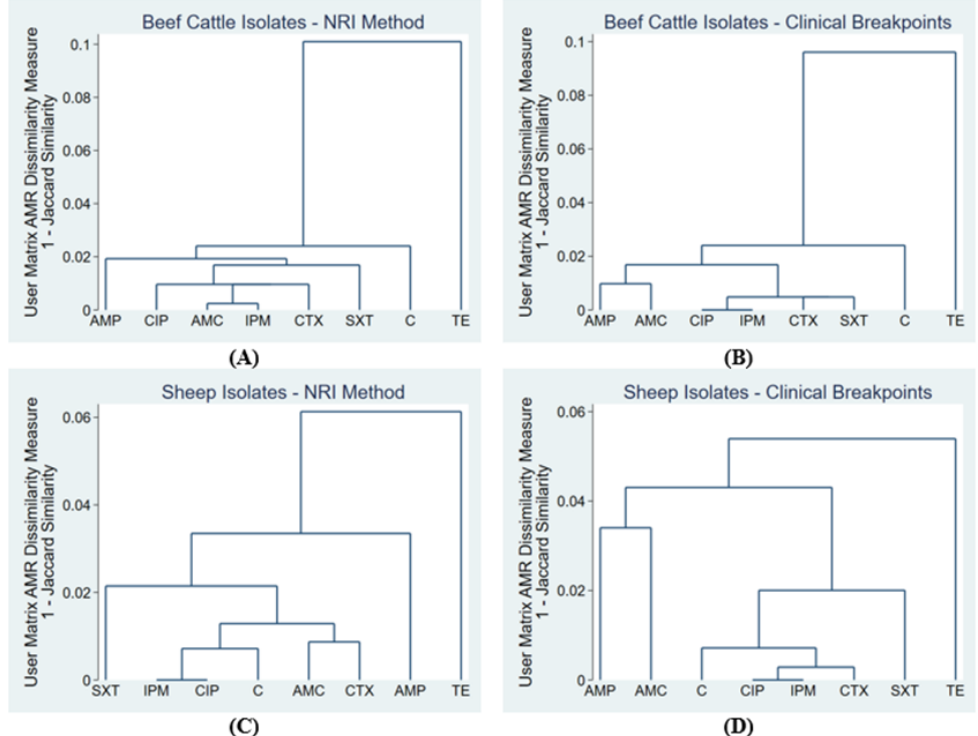
Figure 1. Single-linkage clustering dendrograms for non-susceptibility to eight antimicrobials ( A ) based on the NRI CO WT values in E. coli isolates from beef cattle fecal samples ( n = 416); ( B ) based on clinical breakpoints, in E. coli isolates from beef cattle fecal samples ( n = 416); ( C ) based on the NRI CO WT values, in E. coli isolates from sheep fecal samples ( n = 699); and ( D ) based on clinical breakpoints, in E. coli isolates from sheep fecal samples ( n = 699). AMP = ampicillin, AMC = amoxicillin/clavulanic acid, C = chloramphenicol, CIP = ciprofloxacin, CTX = cefotaxime, IPM = imipenem, SXT = sulfamethoxazole-trimethoprim, TE = tetracycline.